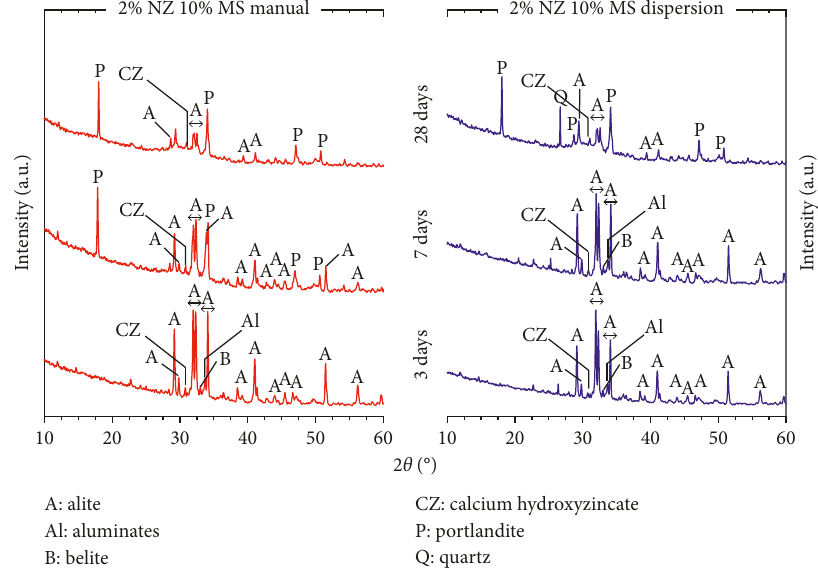
Figure 6: XRD characterization for cement paste with 2 wt.% of nanozinc (NZ) +10 wt.% microsilica